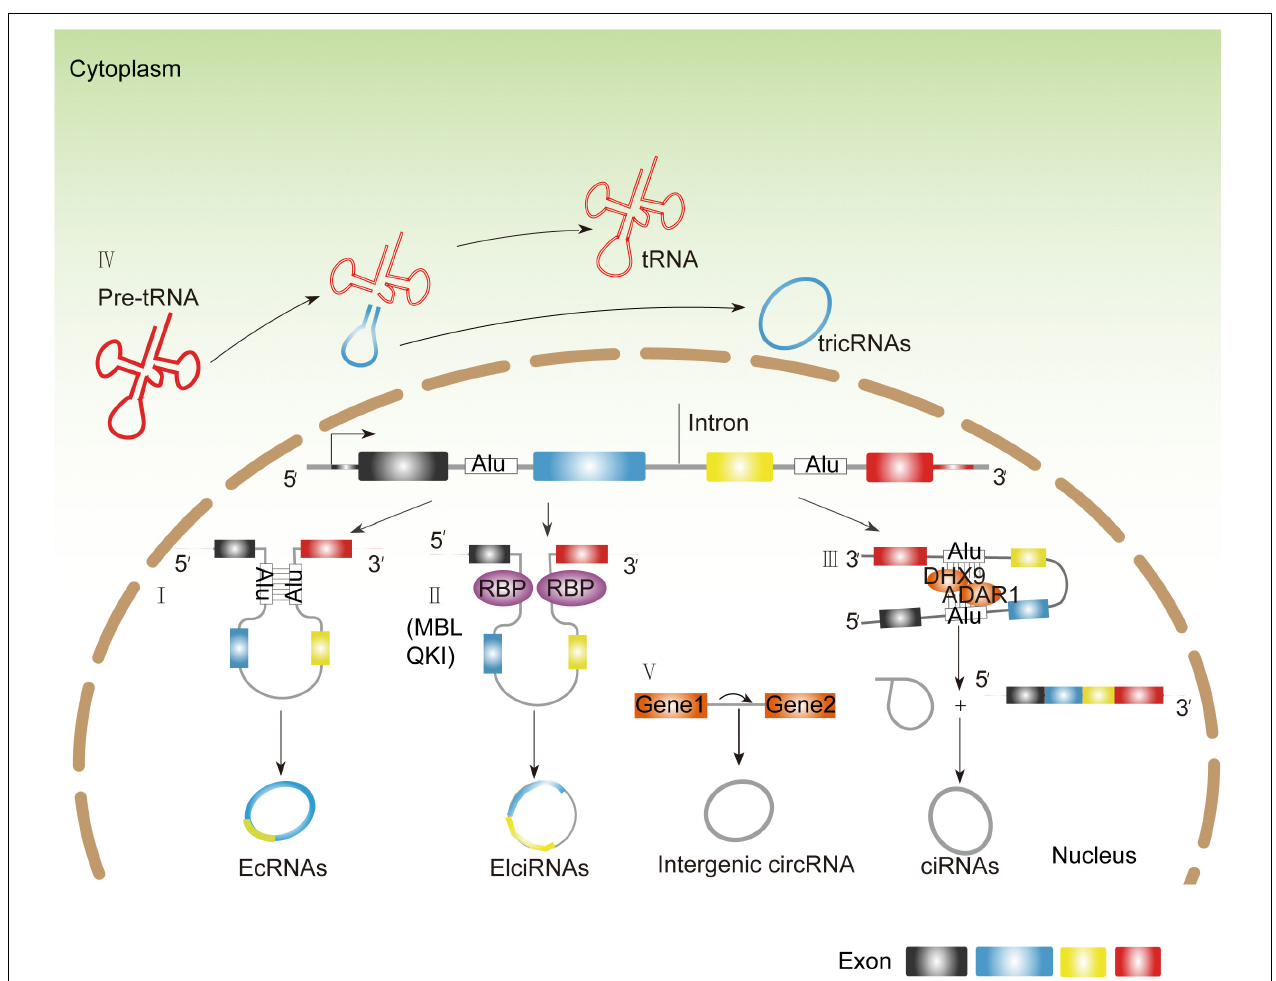
FIGURE 1 | The endogenous biosynthesis of circRNAs. (I) Long flanking introns and inverted repeat elements (such as Alu elements) promote competition between the linear splicing and back-splicing of exons, leading to the generation of EcRNAs. (II) Some RBPs like MBL and QKI can recognize the specific motifs within flanking introns and directly bind on them, dragging two splicing sites close enough to promote back-splicing subsequently. (III) Some RBPs like DHX and ADAR1 disrupt base pairing between inverted repeat elements, allowing the splicing machinery to generate linear mRNA. (IV) TricRNAs are generated from introns spliced from pre-tRNA (V) . Intergenic circRNAs contains two intronic circRNA